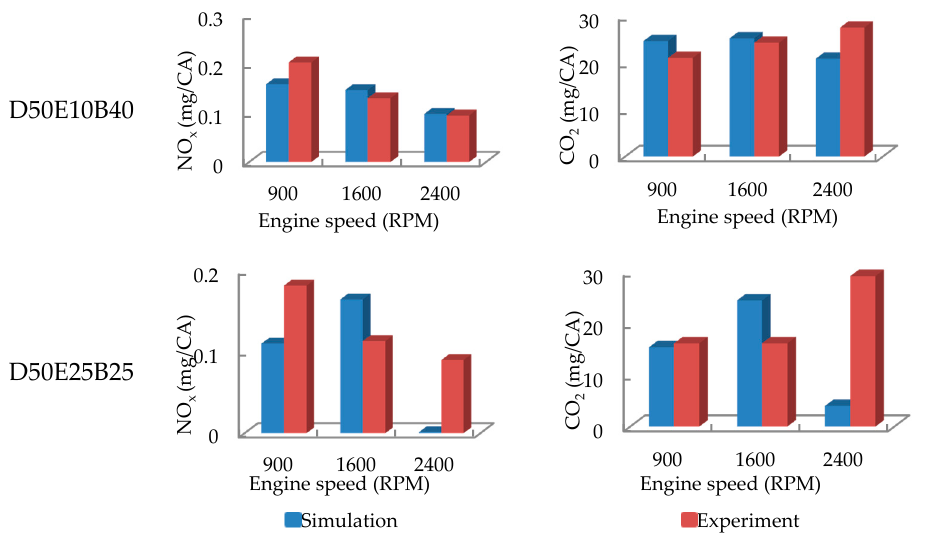
Figure 7. Comparison of emissions from simulations and experiments for D50E10B40 and D50E25B25 blends.